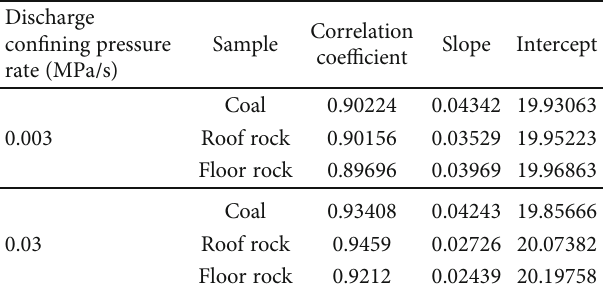
Figure 6: Linear fi tting of mean thermal infrared radiation temperature and stress. Here, (a), (b), and (c) are linear fi tting results of composite coal-rock under con fi ning pressure unloading rates of 0.003MPa/s, 0.03 MPa/s, and 0.05MPa/s, respectively. Table 2: Linear fi tting parameters between T ave and stress at di ff erent pressure unloading